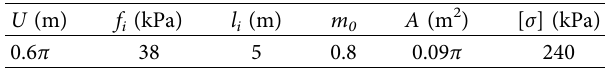
Figure 14: Curves of pile side friction resistance under different pile top loads. Table 7: Pile bearing capacity parameter